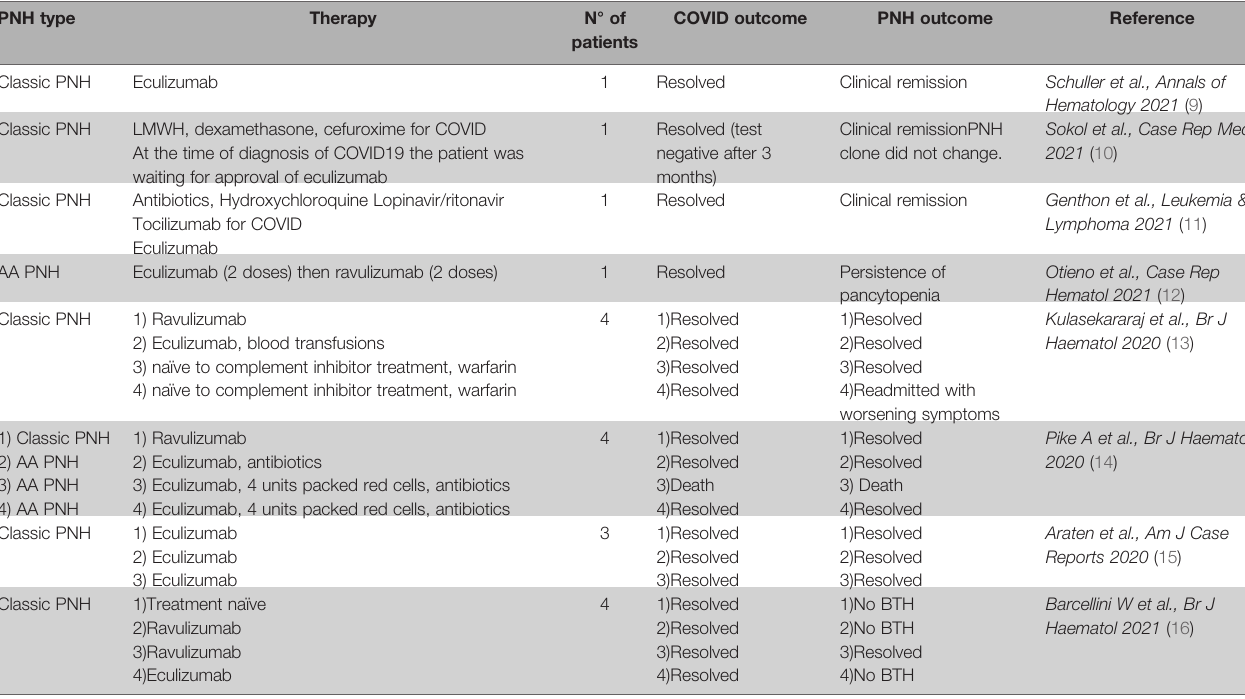
TABLE 1 | Hemolytic fl ares in patients with paroxysmal nocturnal hemoglobinuria during COVID-19